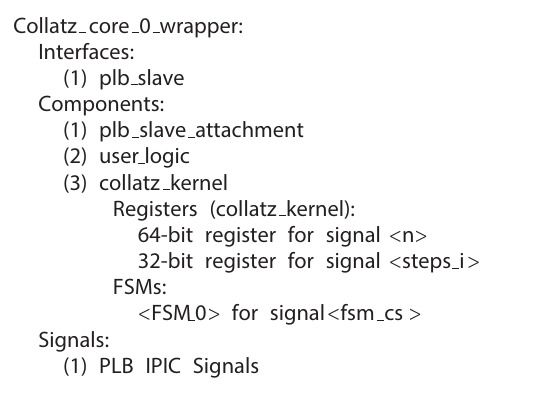
Figure 6: Sample output of HwPMI System Analyzer tool on the Collatz Design, identifying the components, registers, statements, and interfaces to the core.